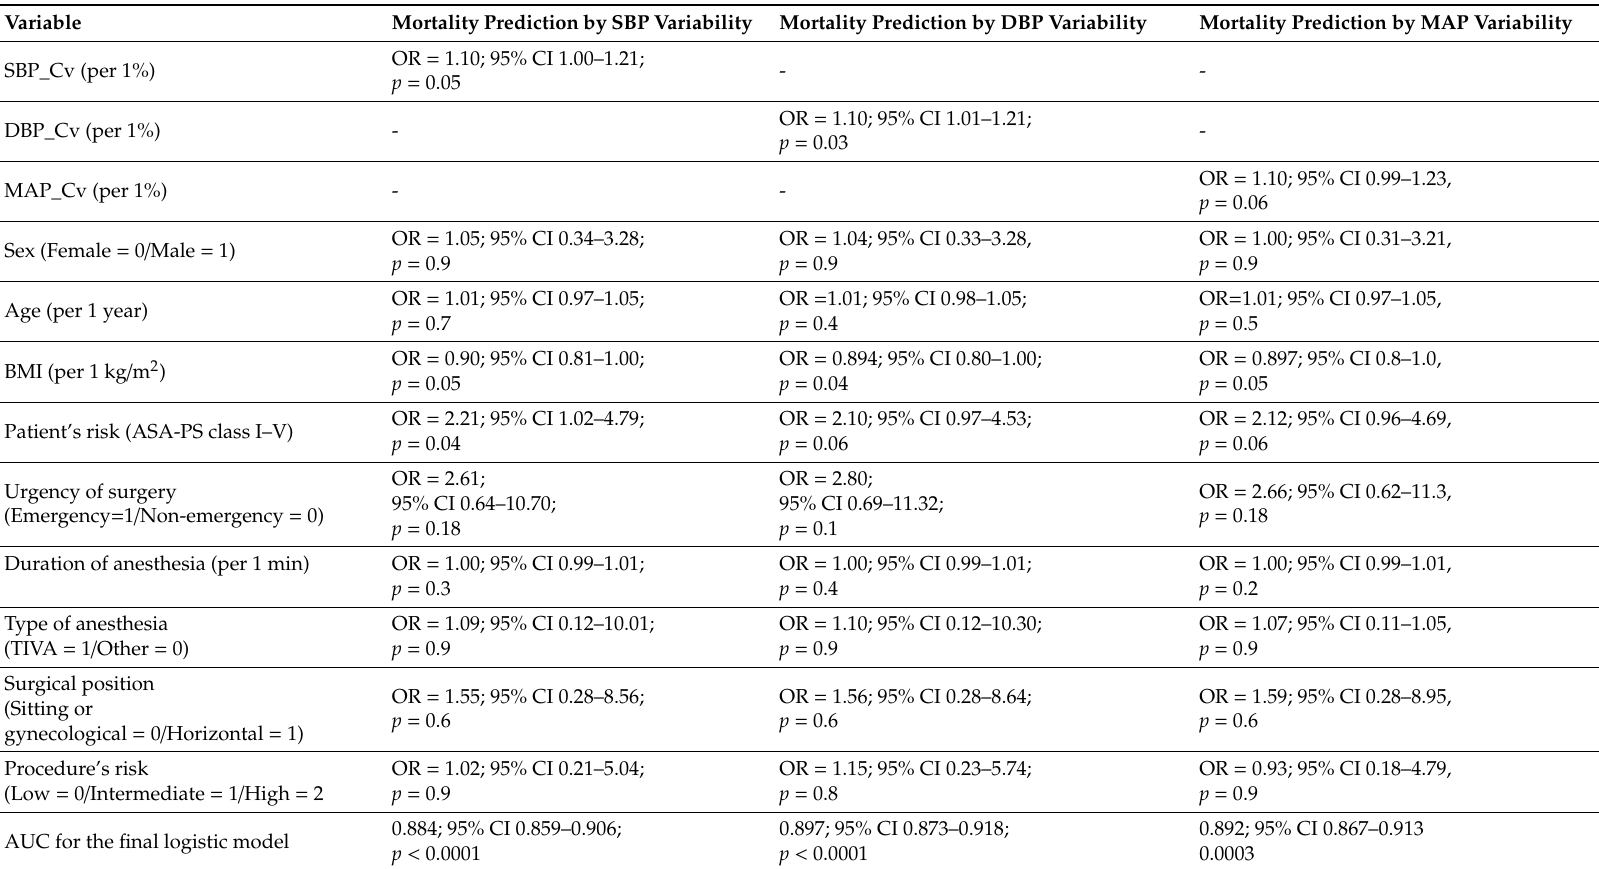
Table 4. Impact of blood pressure variability on postoperative mortality in logistic